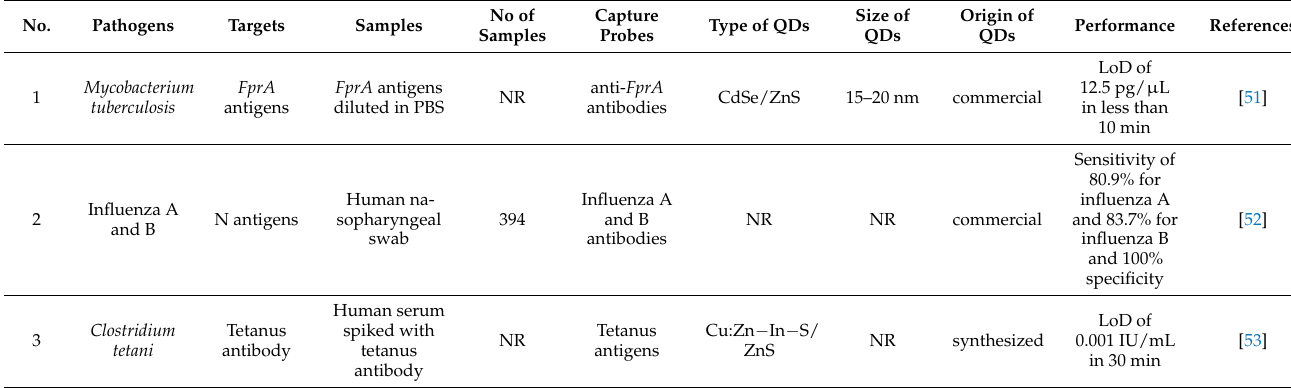
Table 1. Summary of quantum dot-based lateral flow